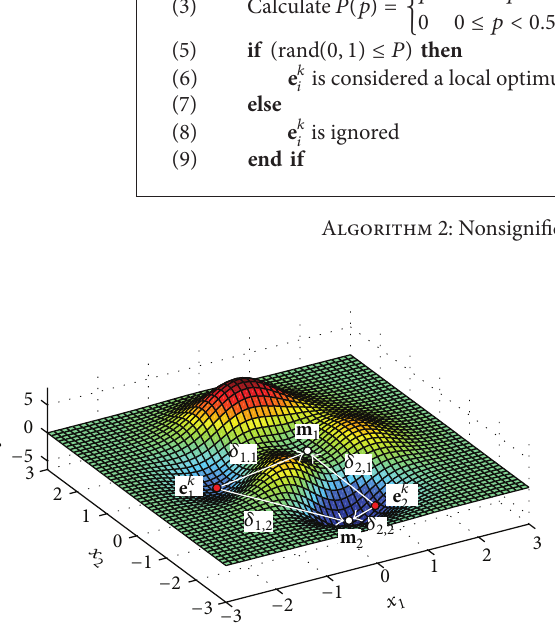
Figure 2: Graphical illustration of the significant fitness value rule process.